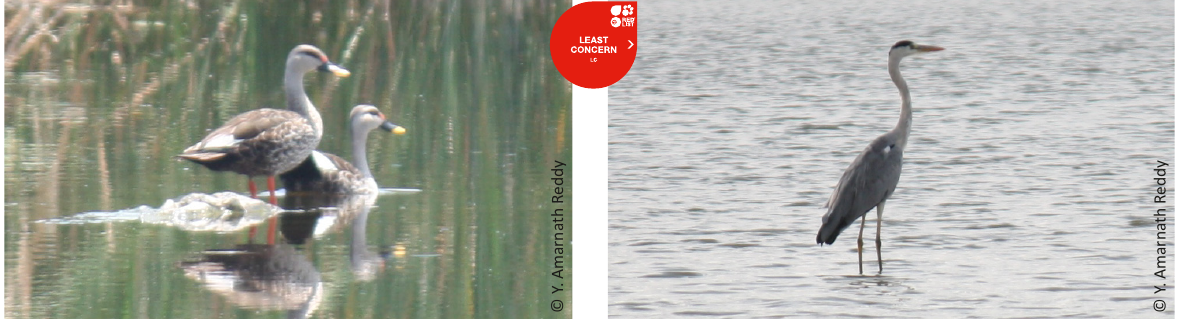
Image 2. Ardea cinerea Grey Heron